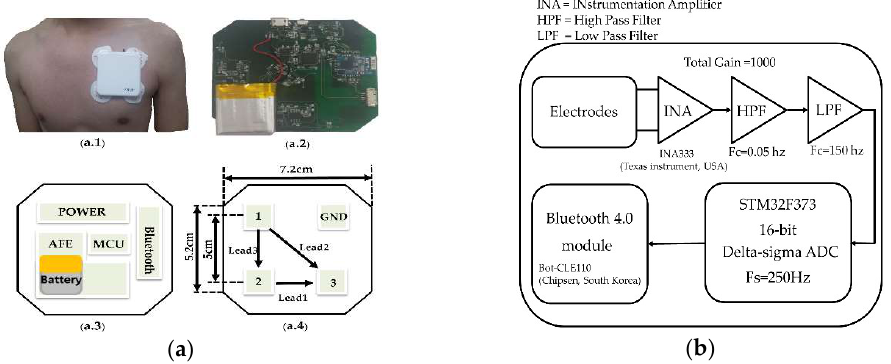
Figure 1. ( a.1 ) Picture of the device attached on a patient. ( a.2 ) Customized circuit. ( a.3 ) Components of the front side. ( a.4 ) Components of the back side. ( b ) Block diagram showing the signal processing and data acquisition of the device.